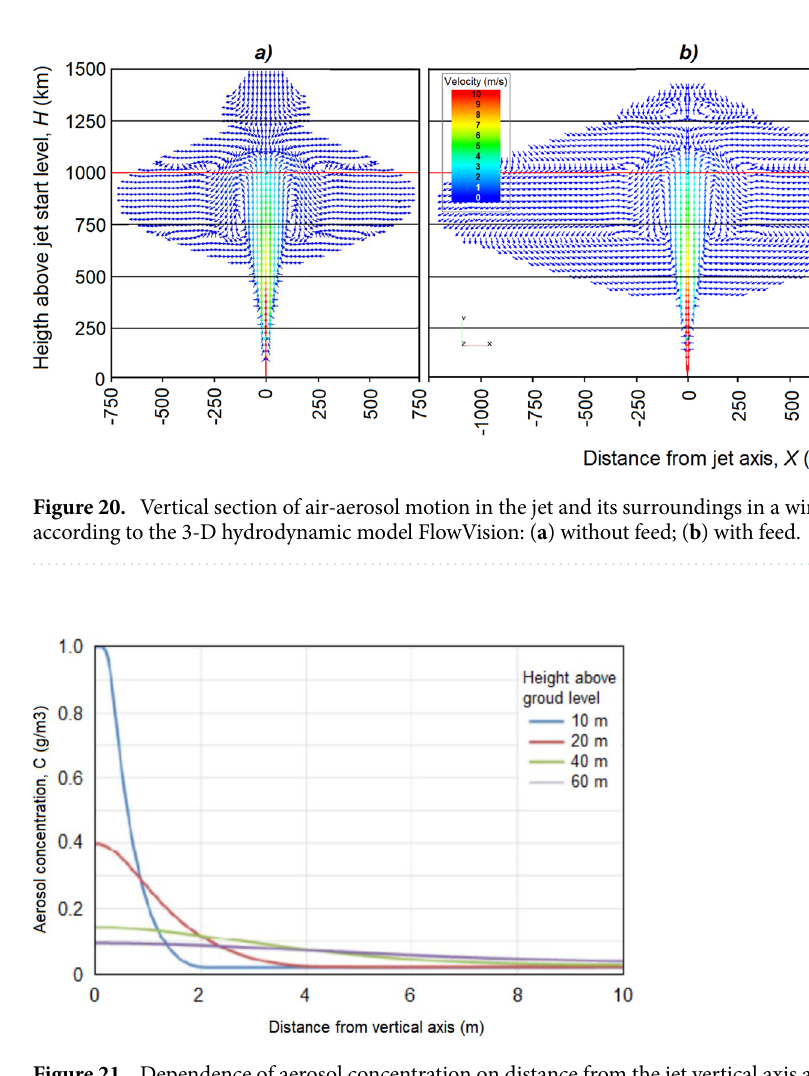
Figure 21. Dependence of aerosol concentration on distance from the jet vertical axis at heights 10 m, 20 m, 40 m and 60 m.